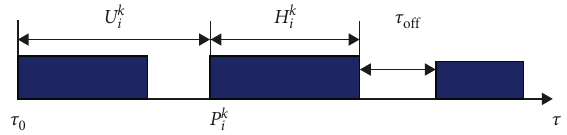
Figure 3: Illustration the handoff mechanism of PU on the